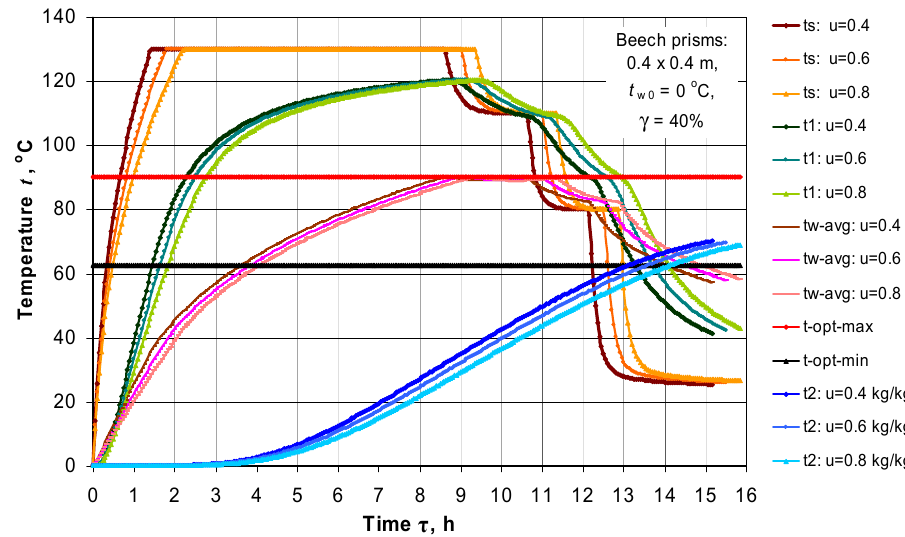
Figure 4. Changes in t s , t w-avg , and t in 2 characteristic points t 1 and t 2 of the prisms with d × b = 0.4 × 0.4 m and γ = 40% during their steaming in an autoclave and subsequent conditioning, depending on u and τ .